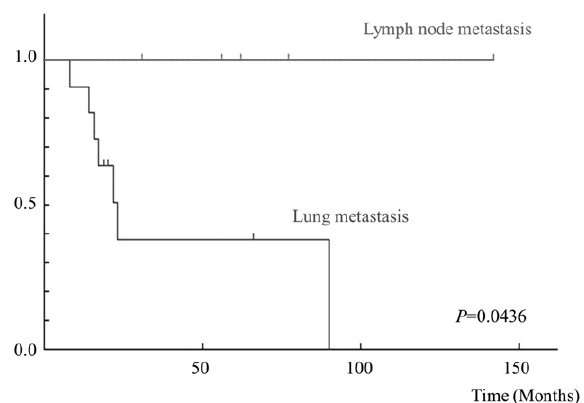
Figure 1. Kaplan – Meier overall survival curves according to regions of